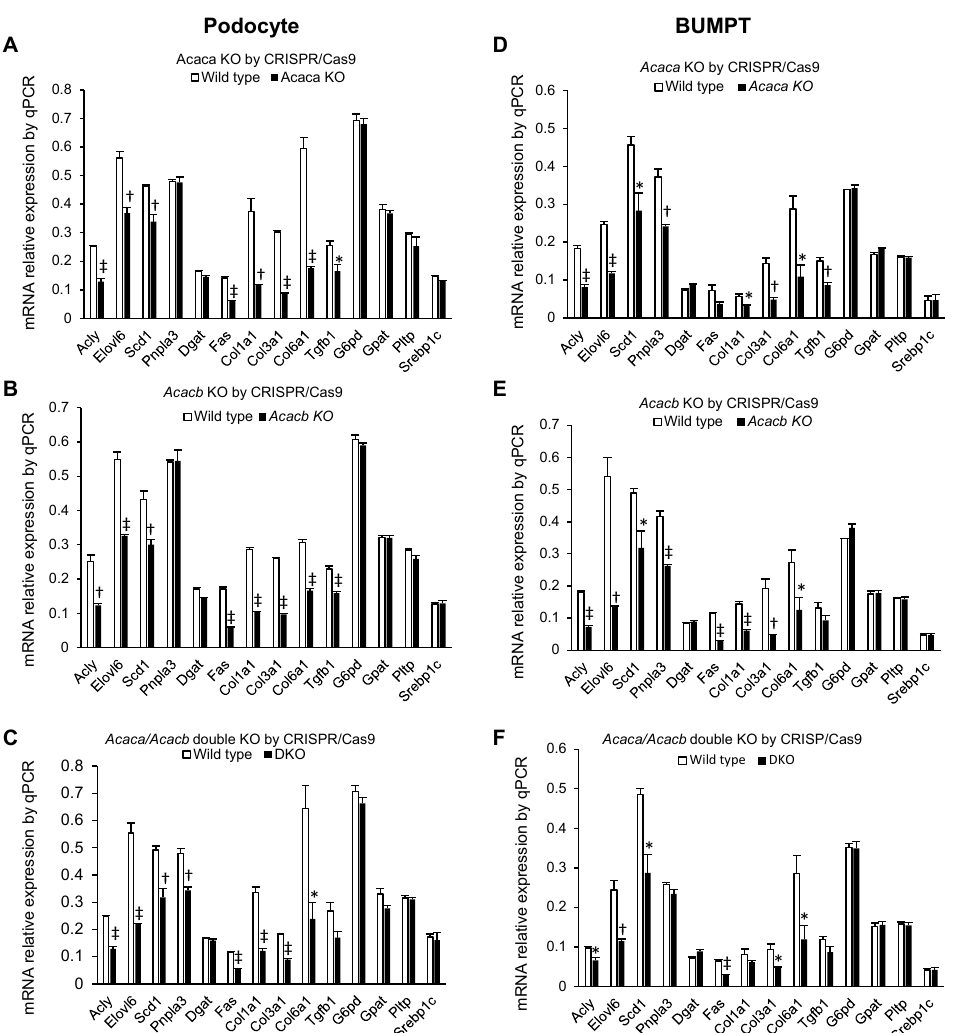
Figure 3. Comparing mRNA relative expression of gene markers in Acaca KO, Acacb KO, and Acaca/Acacb double KO using CRISPR/Cas9 in podocytes ( A – C ) and BUMPT cells ( D – F ) compared with wild ‐ type cell lines. Values are mean and standard error in triplicate. * p < 0.05, † p < 0.01, ‡ p < 0.001. Number of experiments is 3 in all panels.